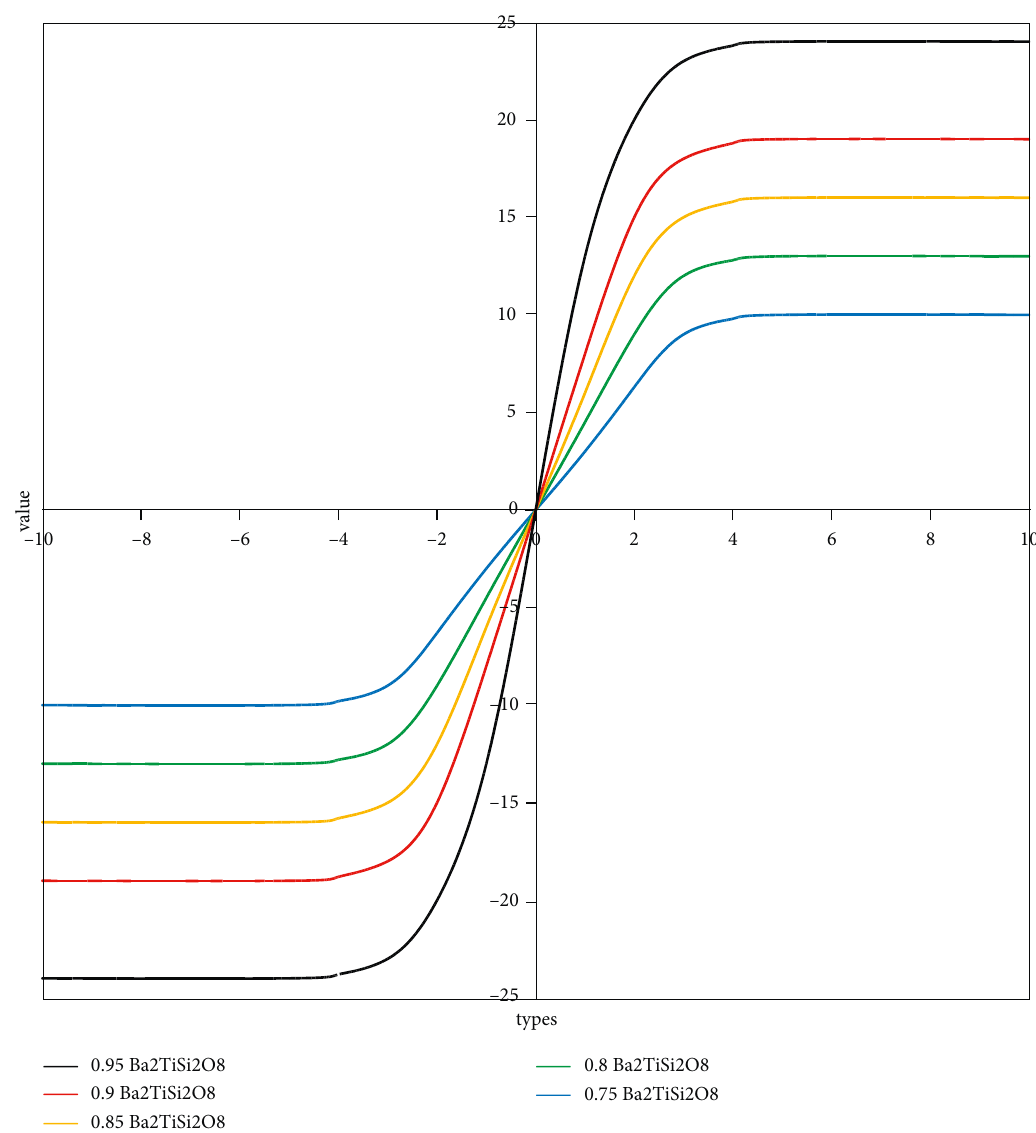
Figure 3: Hysteresis loop of Ba